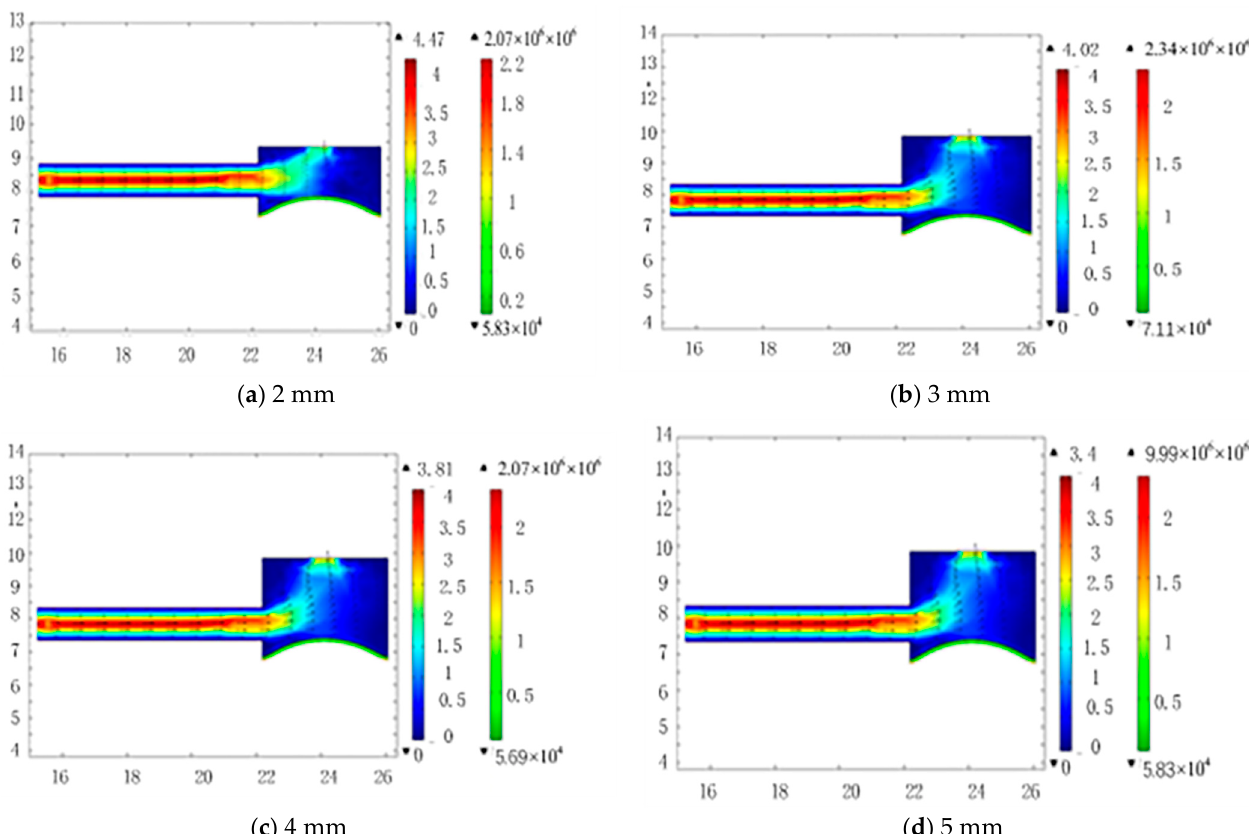
Figure 2. Dependence of fluid flow rate at the inlet of the compressible cavity on cavity height ( a ) 2 mm, ( b ) 3 mm, ( c ) 4 mm, and ( d ) 5 mm (Note: The left label in the legend is the fluid flow rate, the right is the height of the compression chamber).